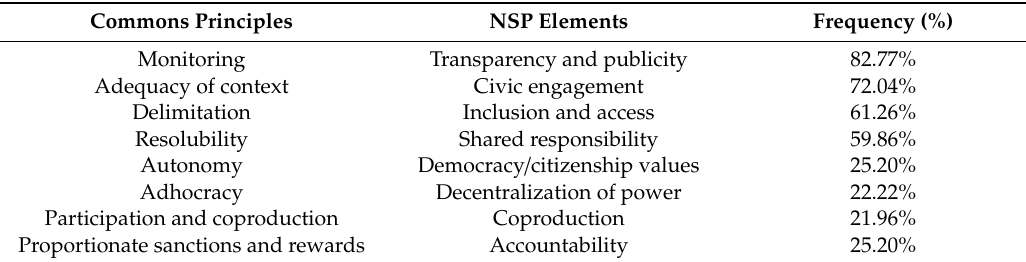
Table 8. Brazilian municipal eGov regarding commons and NSP principles.